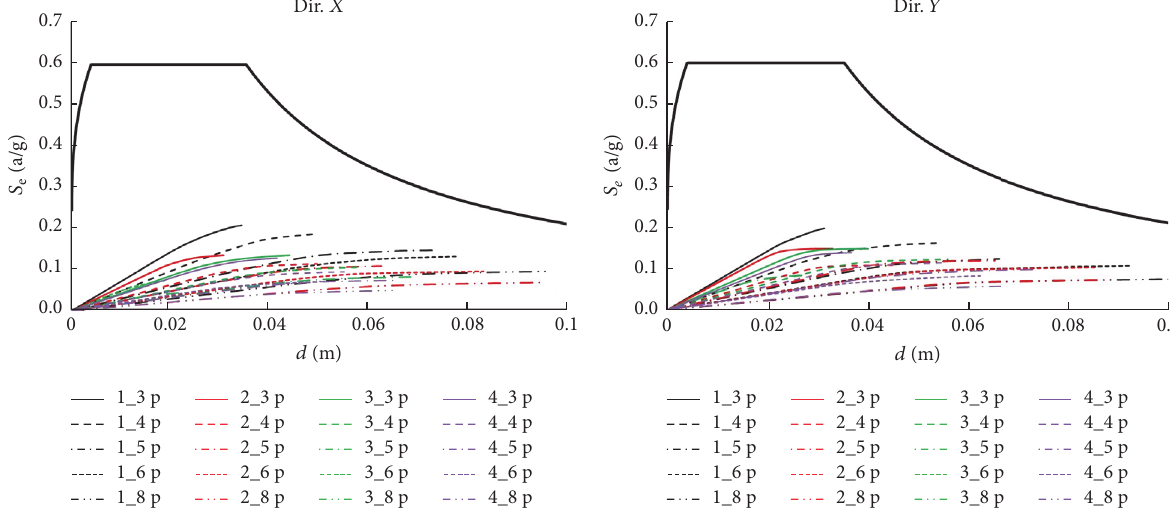
Figure 10: Pushover curves of the bare structures compared with the seismic demand (BDE).